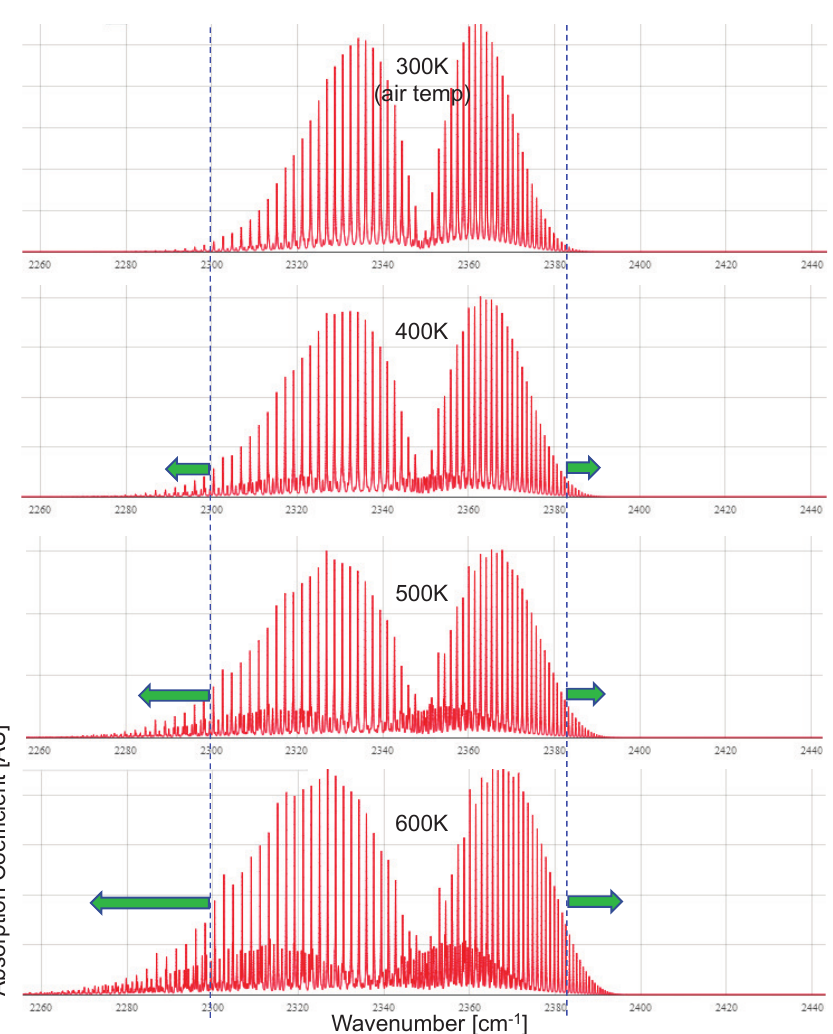
Figure 2. Spectral absorption coefficient variations of carbon dioxide according to different gas